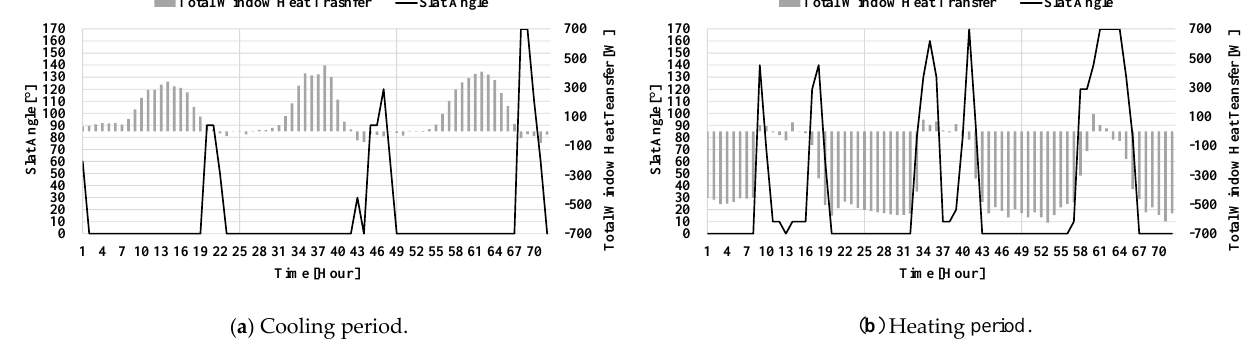
Figure 13. Total window heat transfer with and without ANN optimal control. The daily total window heat transfer without optimal control was approximately 15,000 W/day on average during the cooling period. By contrast, it was approximately 11,500 W/day on average during the heating period. Therefore, optimal control was ap- plied to reduce the total window heat transfer. The daily total window heat transfer with optimal control decreased to approximately 2000 W/day on average during the cooling period and to approximately 10,000 W/day on average during the heating period. The optimal control model was expected to decrease window heat transfer by 86% and 13% during the cooling and heating periods, respectively. The window peak load and monthly window load were analyzed to identify changes in the load through the window. Figure 14 shows these changes with and without optimal control. Figure 14. Reduction in window heat transfer with and without ANN optimal control. When optimal control was applied, the window peak load decreased by 89.6% and 55.9% during the cooling and heating periods, respectively. Furthermore, the monthly window heat transfer decreased by 86.3% and 9.7% during the cooling and heating periods, respectively. Therefore, if the optimal control model is applied, the building energy load through the window is expected to be reduced, and an active response to the load change is possible. In this study, the slat angle response of the optimal control model was analyzed according to the analysis shown above. Figure 15 presents the changes in slat angle under optimal control.